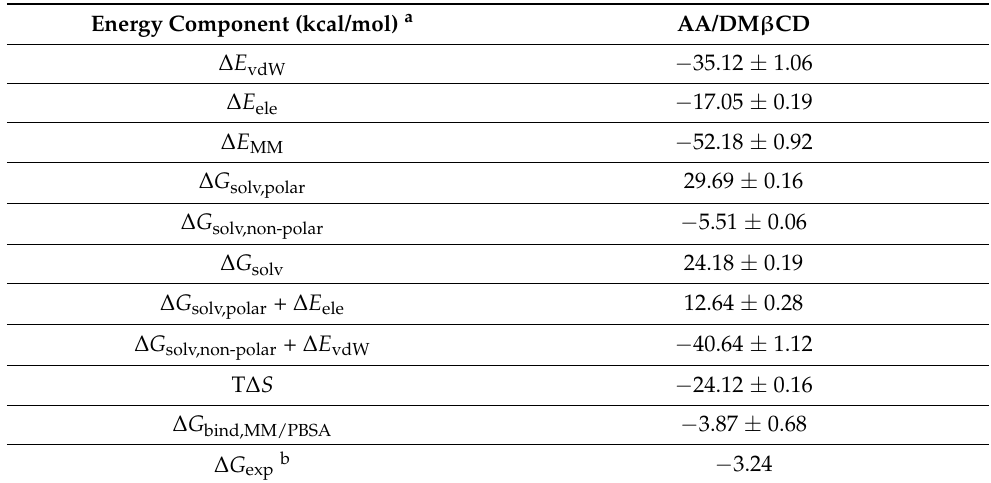
comprising polar ( ∆ G solv,polar ) and non-polar ( ∆ G solv,non-polar ) terms; ∆ S , entropy. b Data from Table 2.